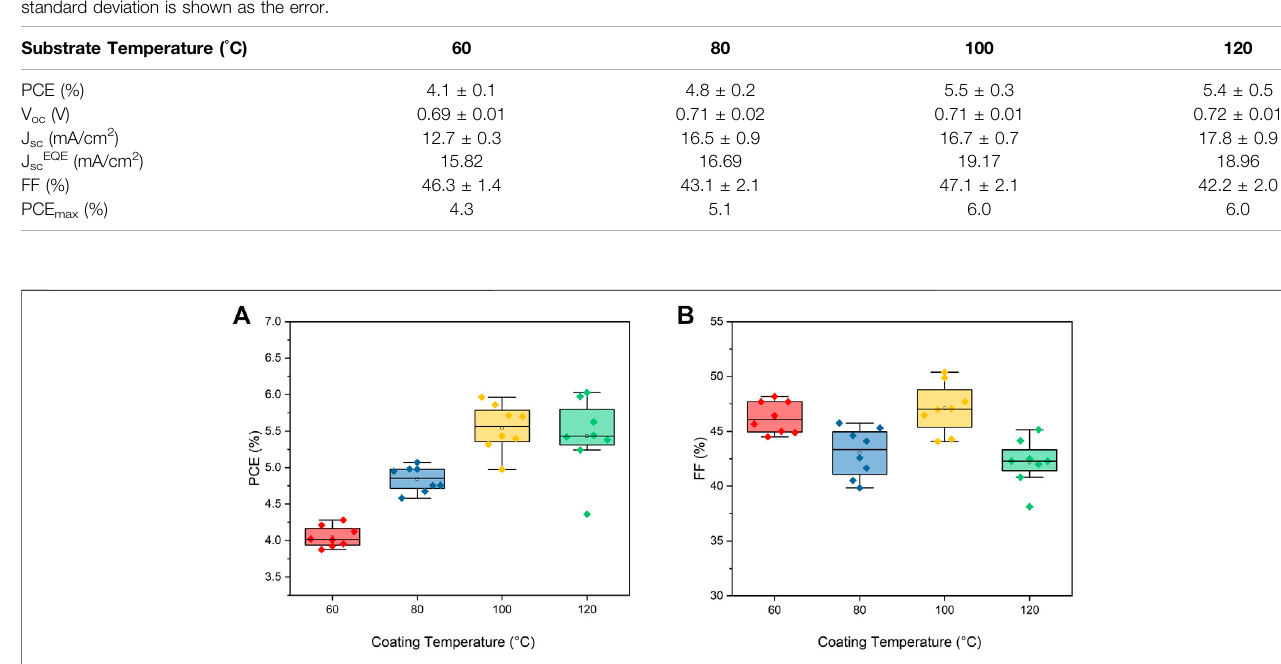
Frontiers in Nanotechnology |